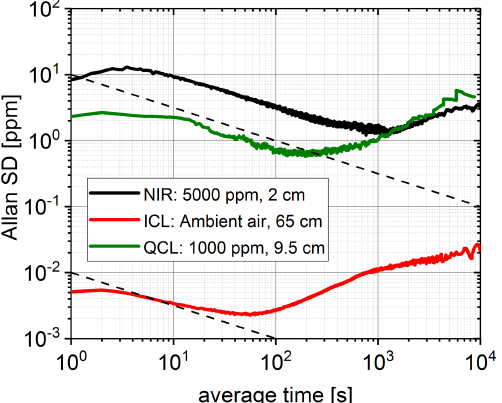
problem would take place and the linear relationship between measured concentration and set point concentration would be lost.